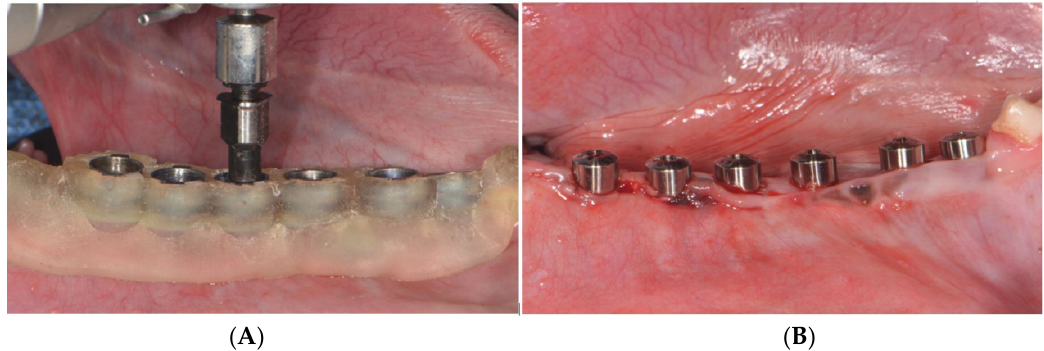
Figure 2. ( A ) Clinical image with surgical guide in place. ( B ) Clinical image with healing abutments in place.